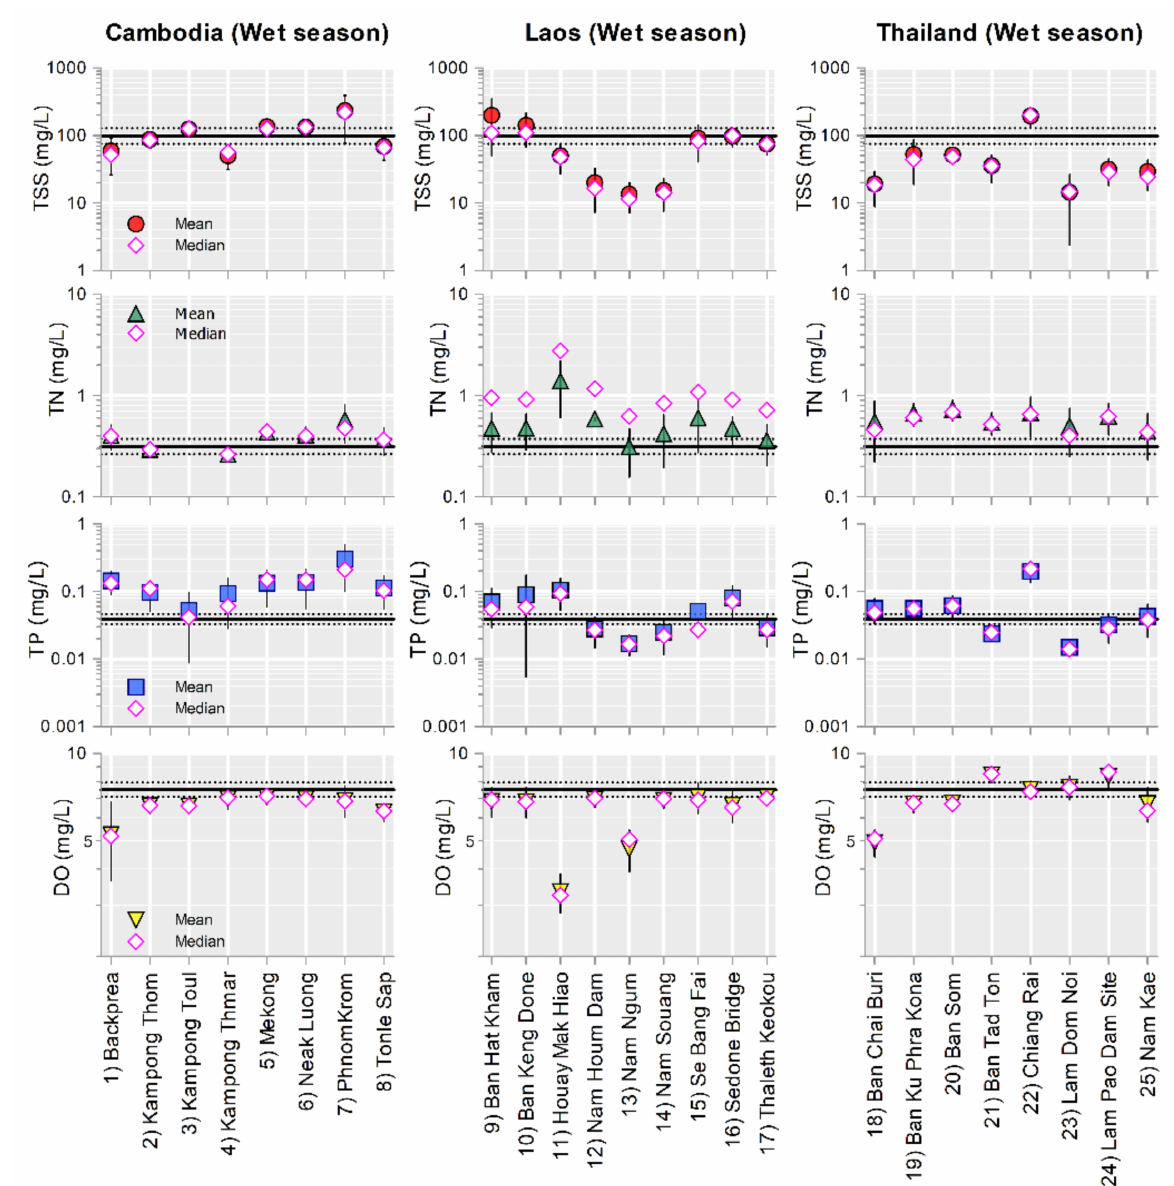
Figure 4. Mean TSS, TN, TP, and DO concentrations for the wet season in Cambodia, Laos, and Thailand. Black solid horizontal lines represent reference values with dotted lines corresponding to the 95% confidence